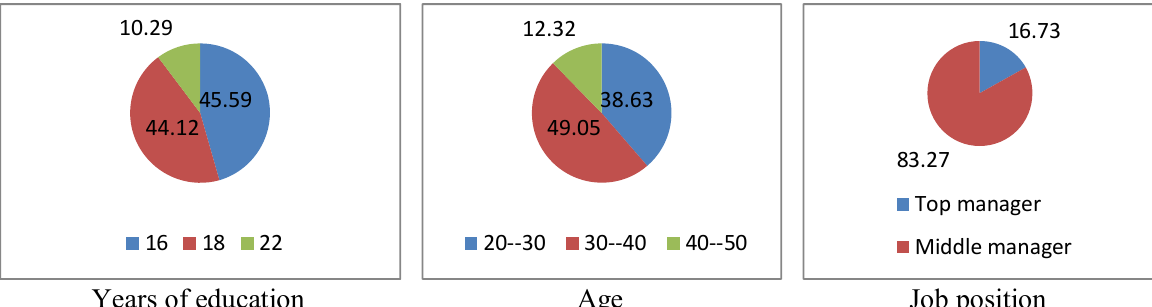
Fig. 2. Personal characteristics of the participants